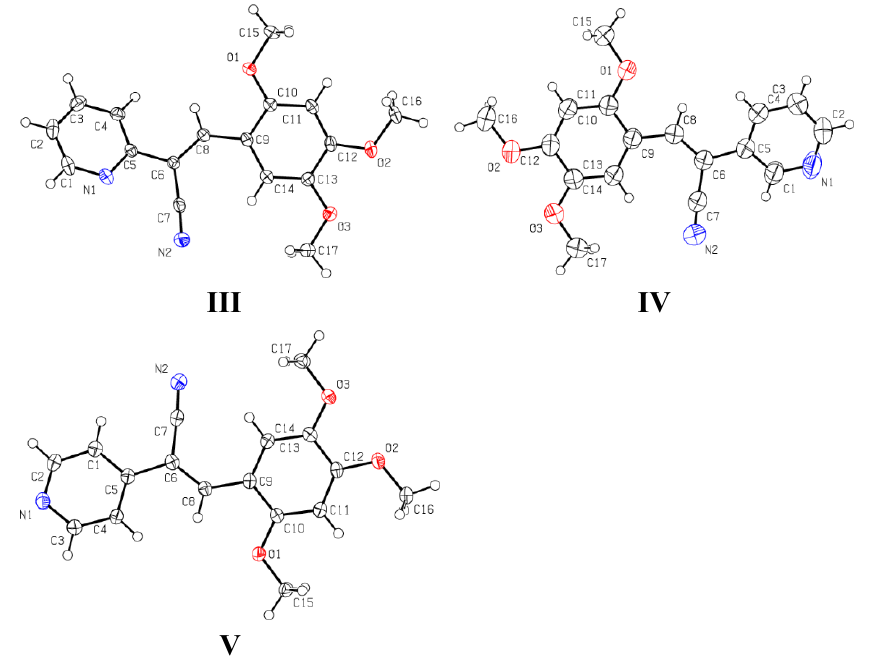
Figure 13. Displacement ellipsoid plots (50% probability level) of III – V. Table 5. Select bond lengths (Å) for the molecular structures of III – V . Assigned [ 77 ] Assigned Double bond C sp2 =C sp2 (overall)1.316 * with Ar. 1.339